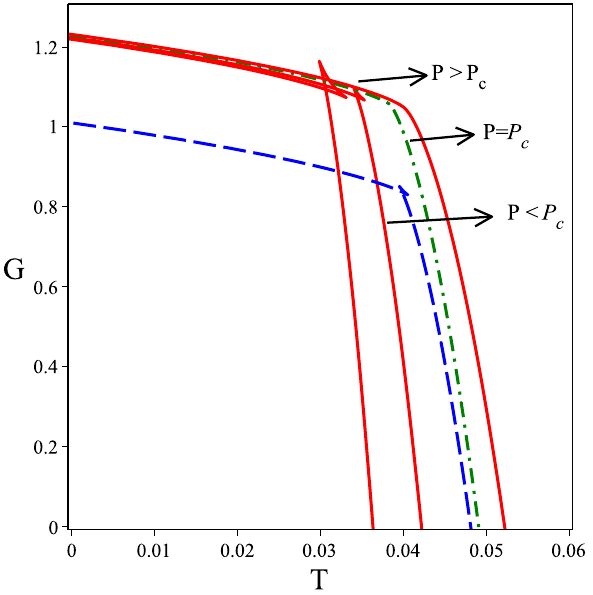
Fig. 7 The behavior of G for our solution in terms of T for P = 0 . 003 , 0 . 002669 , 0 . 002 , 0 . 0015 (right to left) and Q = 1, compared to the RN-AdS metric (dashed line) for P = 0 . 002669, Q = 1